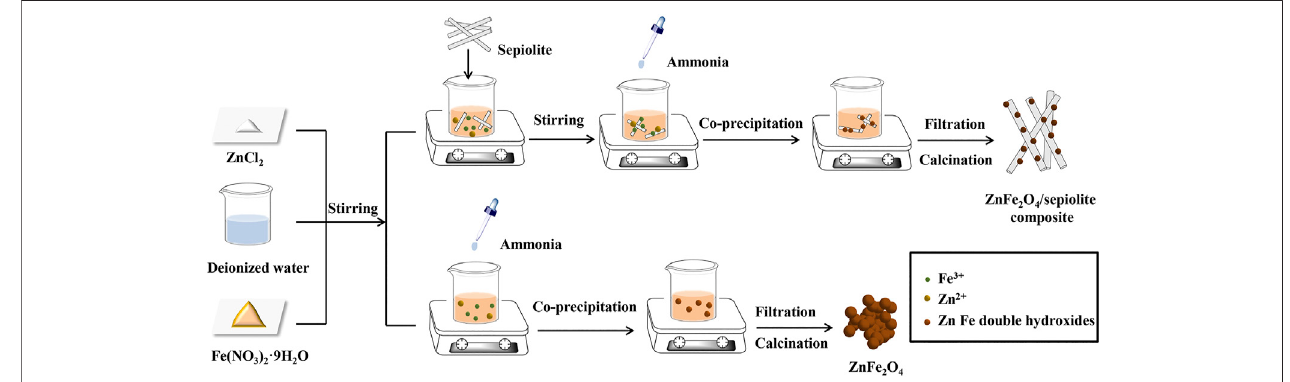
FIGURE 1 | Schematic for the fabrication of ZF-Sep